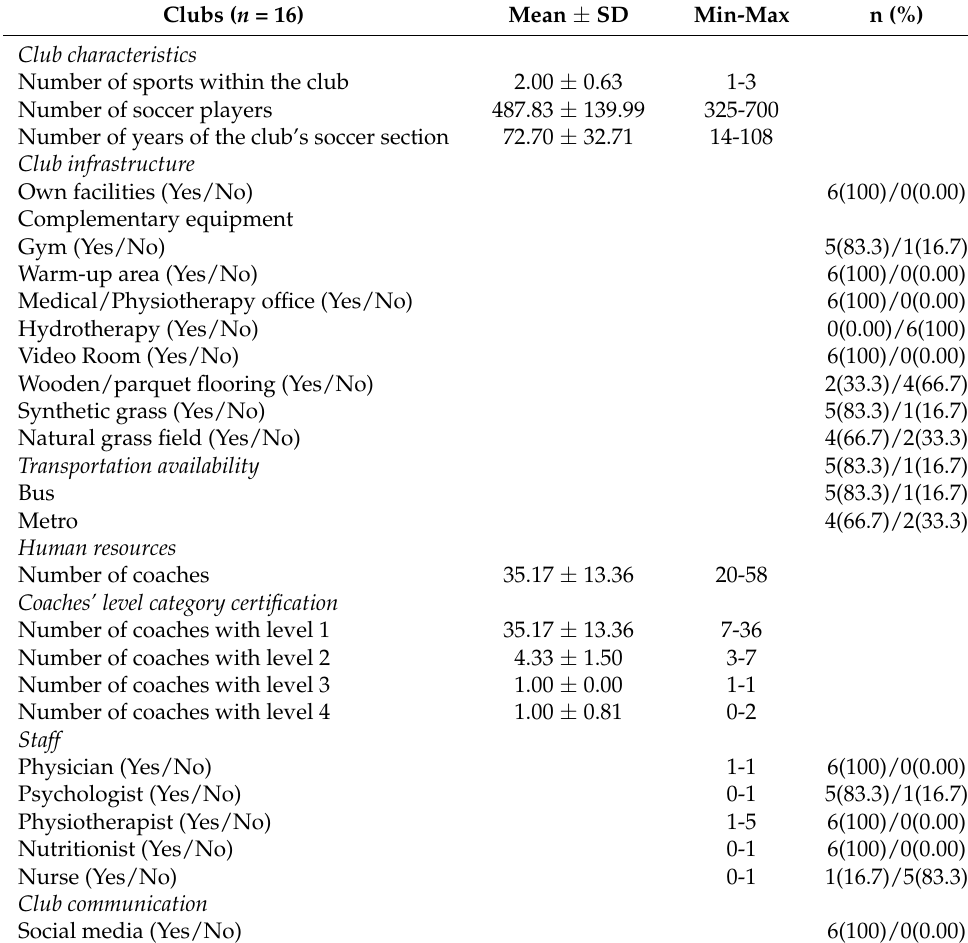
Table 7. Descriptive statistics for clubs’